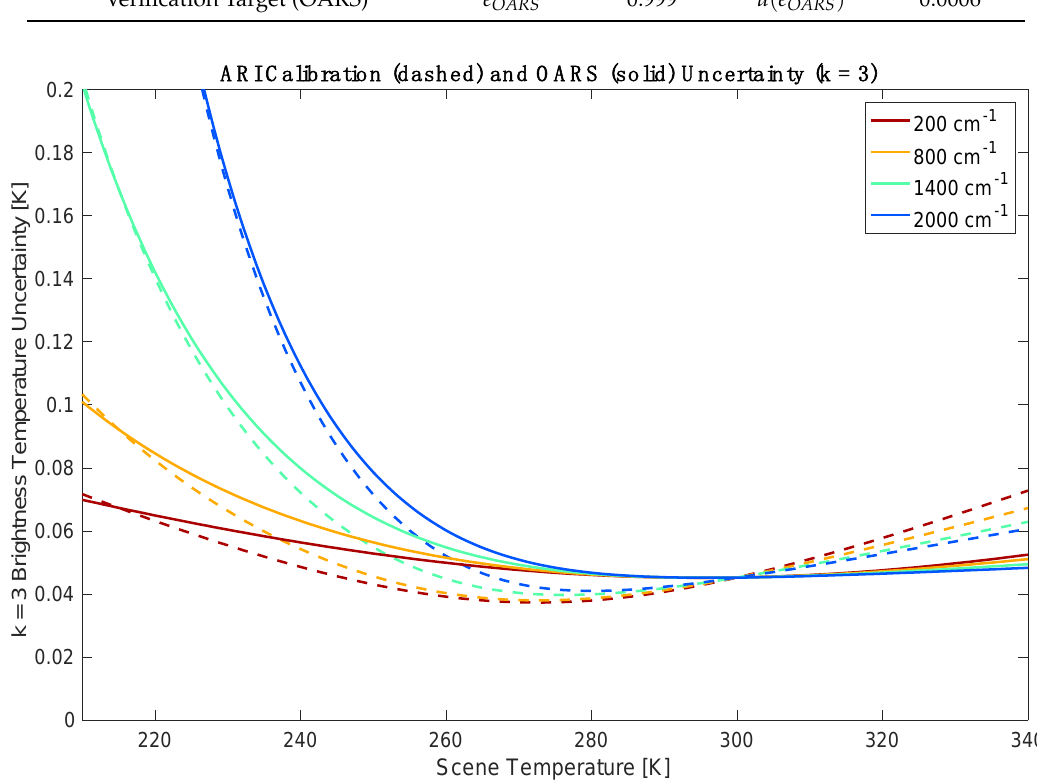
Figure 9. Predicted vacuum radiometric calibration uncertainty (dashed) and calibration verification source uncertainty (solid) (k = 3).